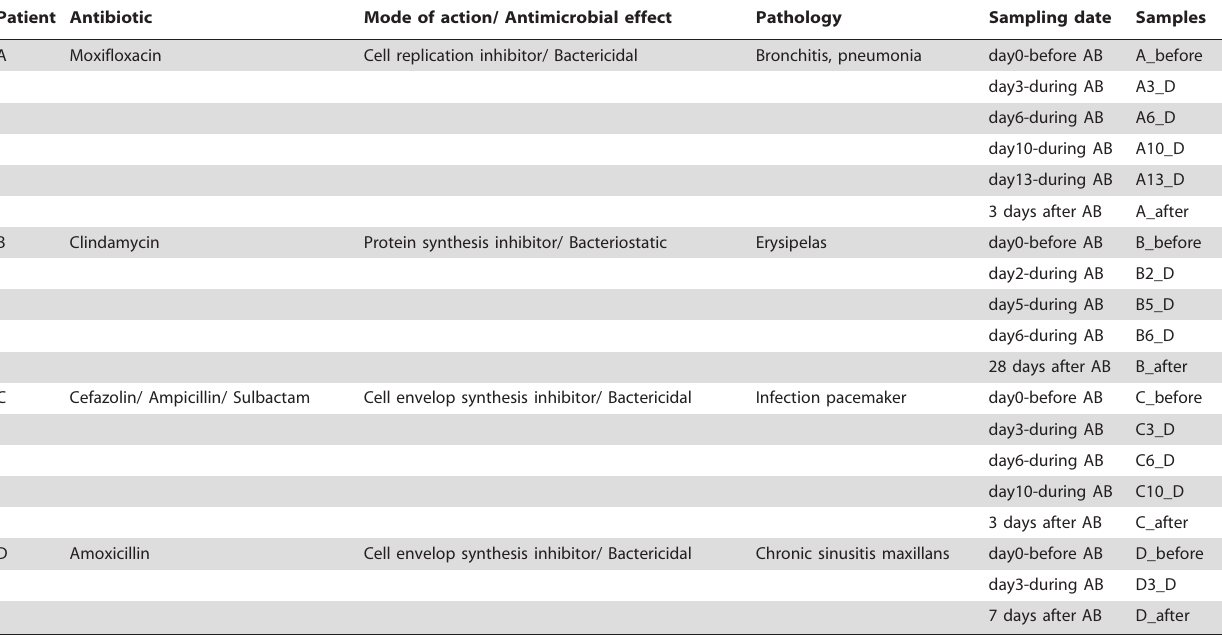
Table 1. Main features of the follow-up